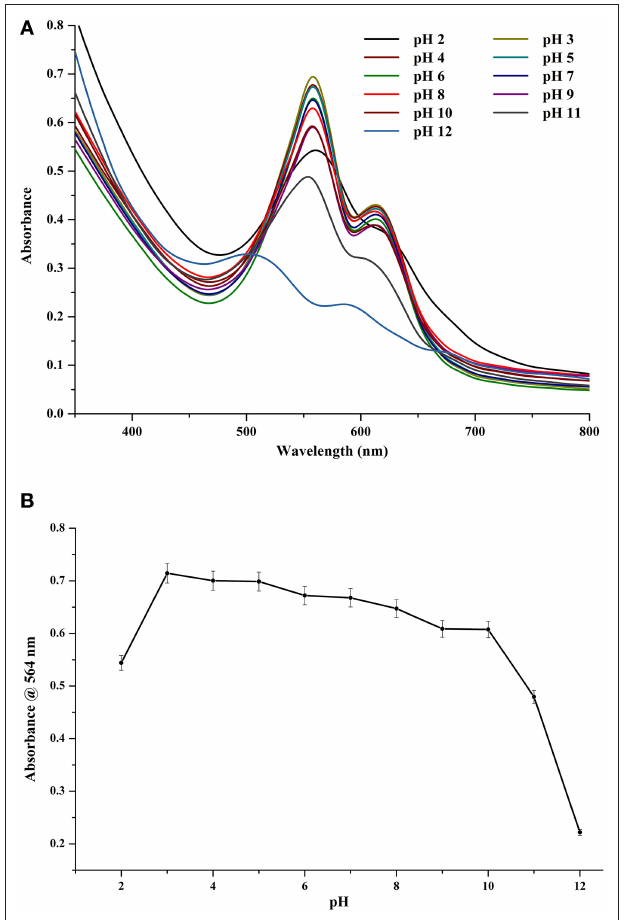
FIGURE 6 | (A) Effect of different light exposure durations on crude CPE extract. (B) Trace absorbance intensities at 564nm for CPE extract for different light exposure durations (light intensity 120 µ mol photons m − 2 s − 1